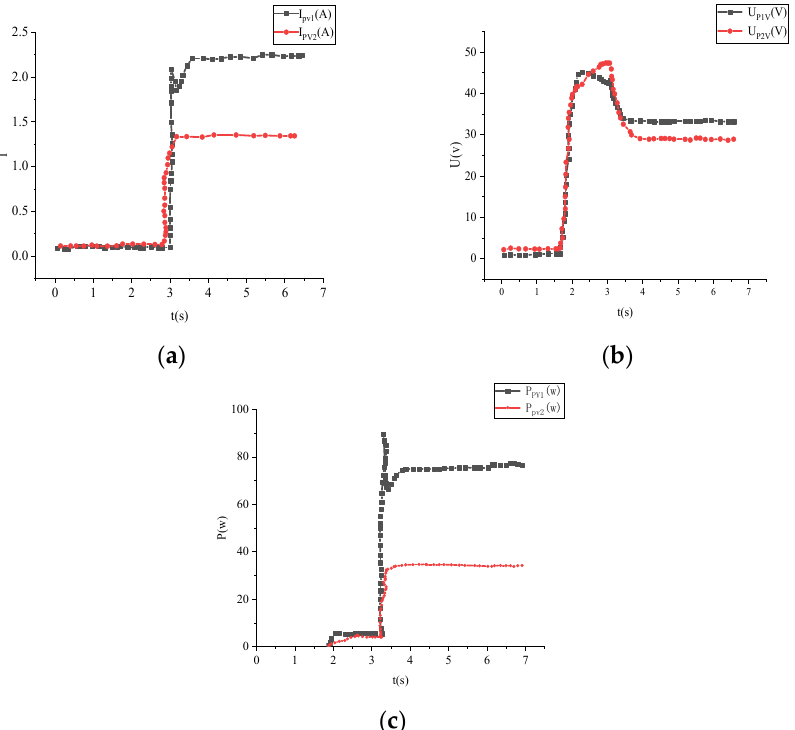
Figure 11. Experimental results of the photovoltaic side of group control: ( a ) pv1/pv2 current curve; ( b ) pv1/pv2 current curve; ( c ) pv1/pv2 power curve.